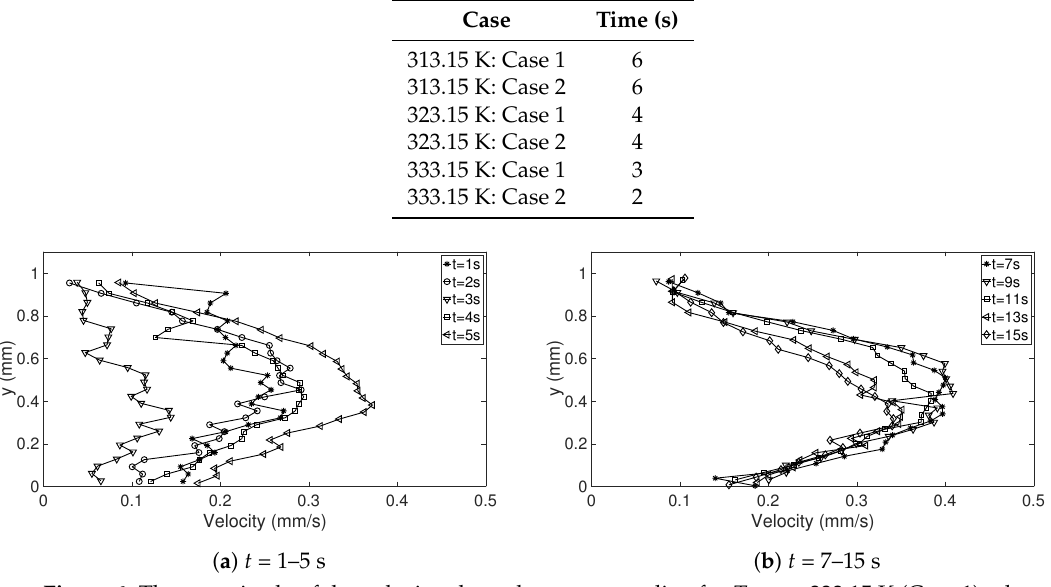
Figure 6. The magnitude of the velocity along the symmetry line for T plate = 333.15 K (Case 1) when t = 1–5 s and t = 7–15